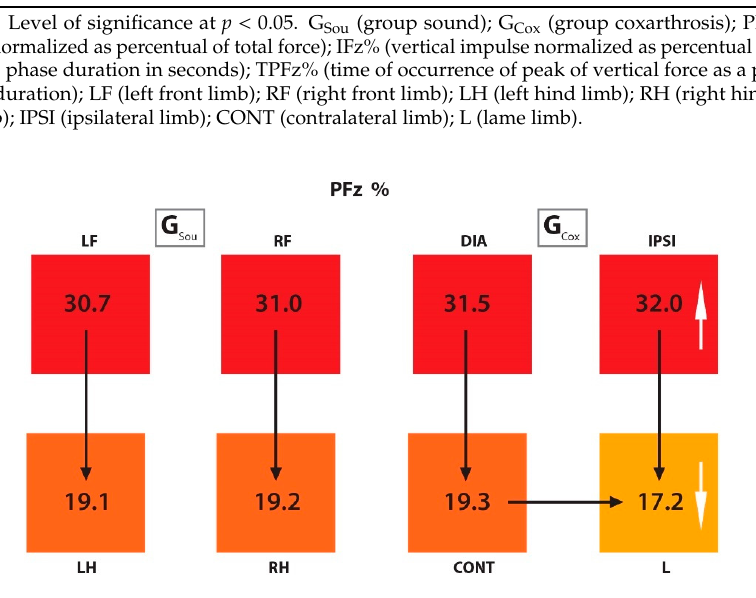
Figure 3. Scheme representing the PFz% of the limbs from G Sou and G Cox . The black arrows represent a significant difference between the limbs within groups (for example, in G Cox , there was a difference between CONT and L limbs), and the white arrows, between the groups (for example, there was a difference between G Sou and G Cox in RF/IPSI and RH/L limbs). The color scale within each group: higher values are represented in darker colors and lower values in lighter colors. PFz% (peak of vertical force normalized as percentual of total force); G Sou (group sound); G Cox (group coxarthrosis); LF (left front limb); RF (right front limb); LH (left hind limb); RH (right hind limb); DIA (diagonal limb); IPSI (ipsilateral limb); CONT (contralateral limb); L (lame limb).